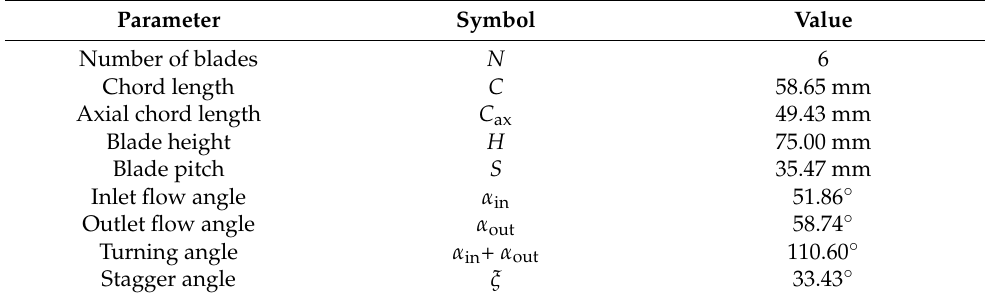
Table 1. Specifications of the linear turbine cascade.